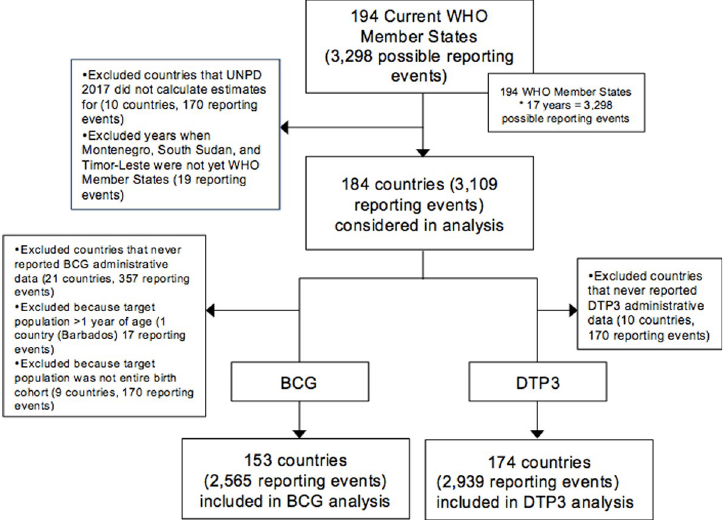
Fig 2. Inclusion and exclusion criteria for assessing reported BCG and DTP3 target population data from 2000 to 2016.